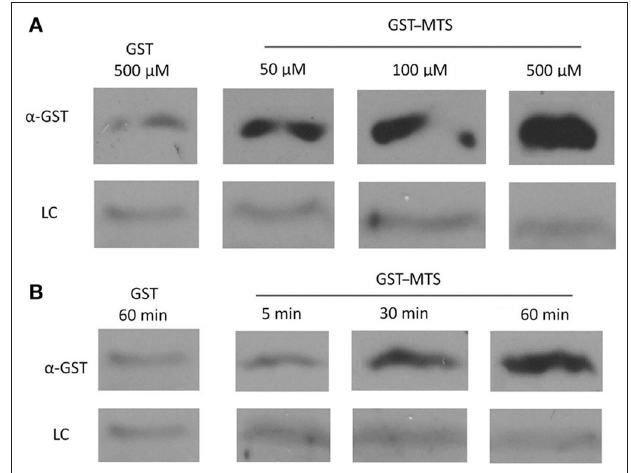
FIgure 4 | CdsL binding domains mapped onto the predicted 3D structure of CdsN reveals two distinct domains. A 3D structure of CdsN was generated based on orthology modeling using 3D-JIGSAW based on the structure of EscN, and used to visualize the CdsL binding domains identified from – 30 – the peptide library binding data. The two CdsL binding domains on CdsN are in blue (residues 221–229) or red (residues 265–270), and the ATP coordinating P-loop region of CdsN is highlighted in magenta. (A) Representation of the predicted CdsN monomeric structure indicating both CdsL binding domains (RSVIVVSTS in blue, TRFARA in red). (B) Structural model showing the location of residues 221–229 (RSVIVVSTS), displayed on one half of the predicted hexameric structure and viewed from the outer face, revealing that the binding domains are exposed to the outside of the hexamer. The P-loop is represented in magenta. (C) Structural model viewed from outside looking toward the central channel showing the location of residues 265–270 (TRFARA), displayed on one half of the predicted hexameric structure revealing that the domain is exposed within the central channel. The P-loop is represented in